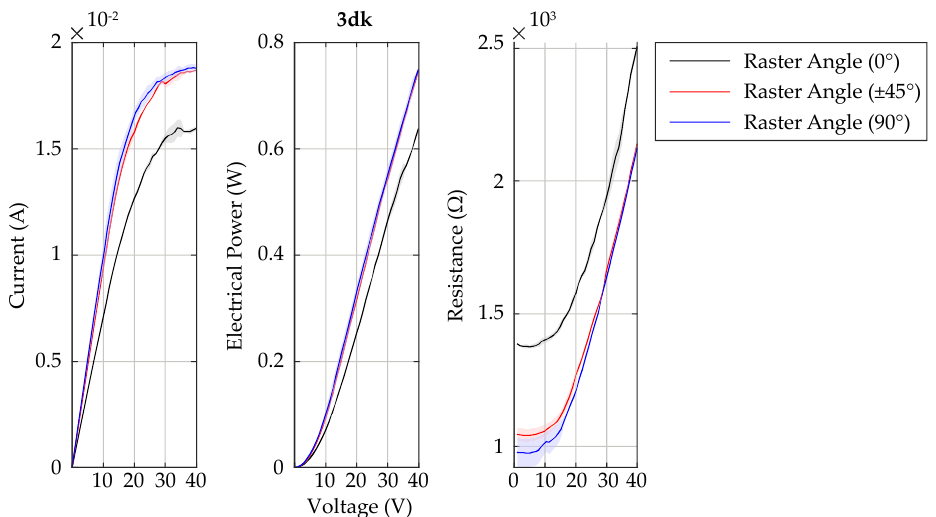
Figure 18. Representation of current, electrical power and resistance depending on voltage of 3dk.